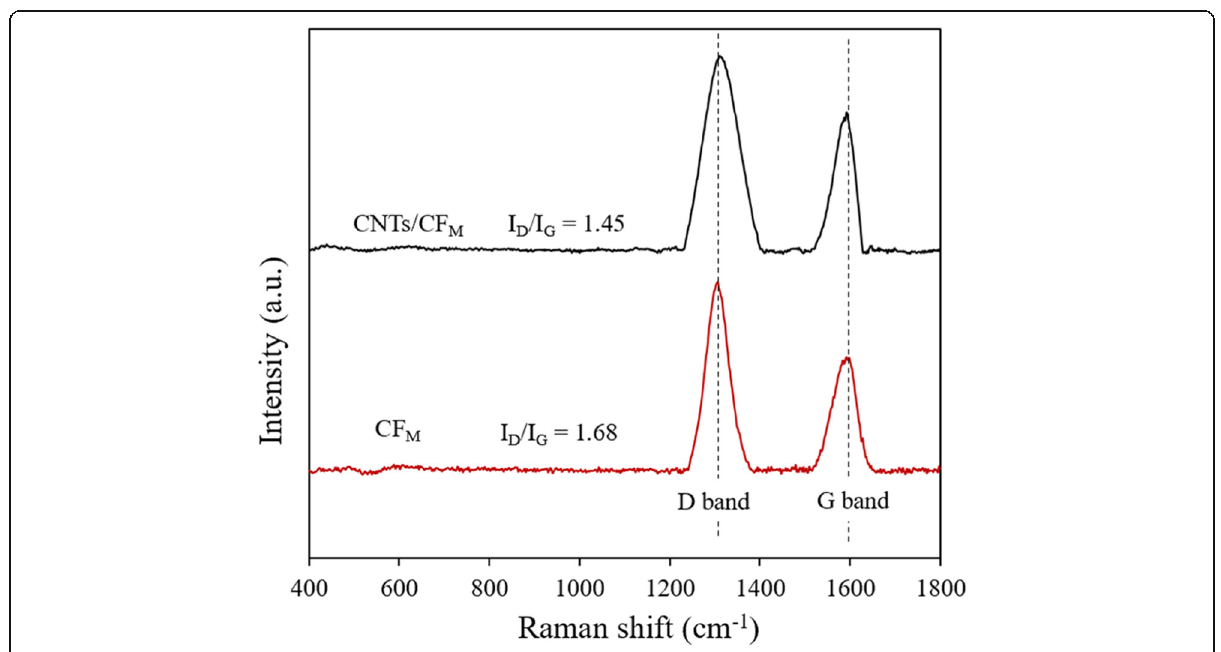
Fig. 4 Raman spectra of CF M and CNTs/CF